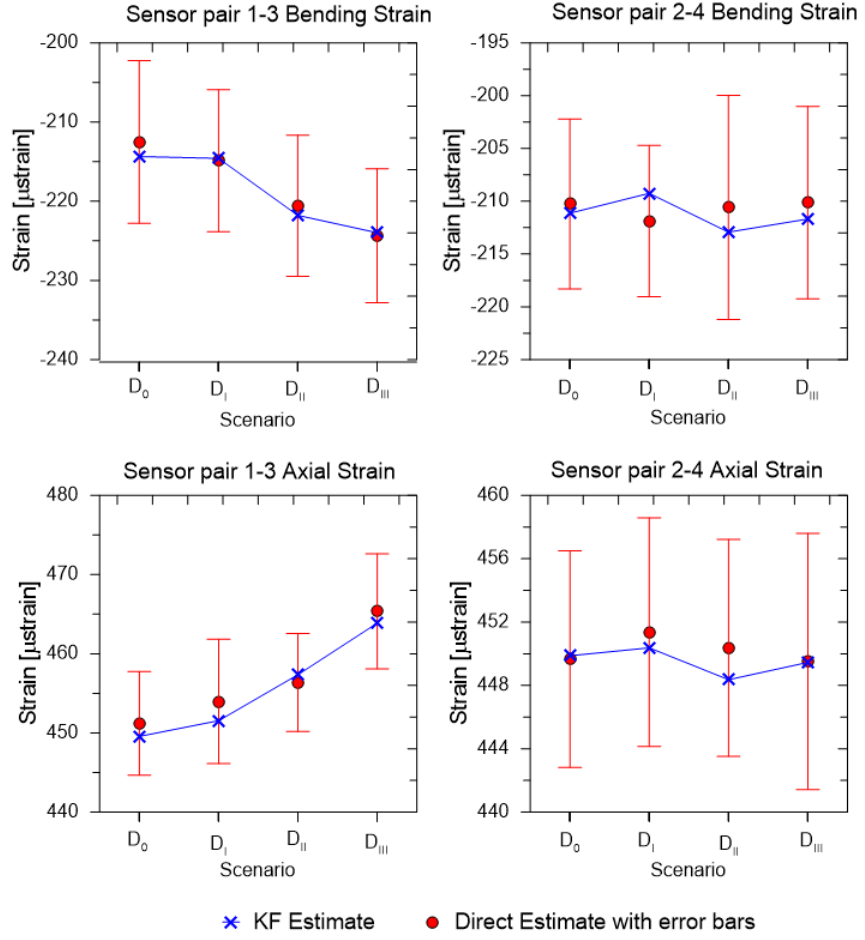
Figure 11. Load estimations for different damage